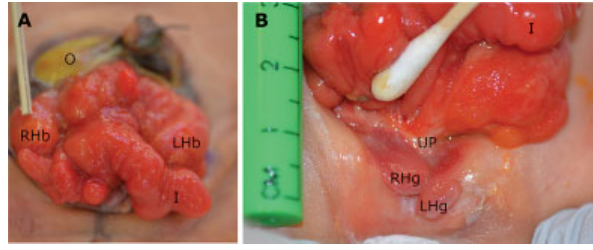
Fig. 2 Preoperative abdominal examination. ( A ) Visible on initial examination are the omphalocele (O), prolapsed ileum (I), and right and left hemibladders (RHb and LHb). ( B ) Re fl ecting the ileum cranially demonstrates the urethral plate (UP) and bi fi d penis with two hemiglans (RHg and